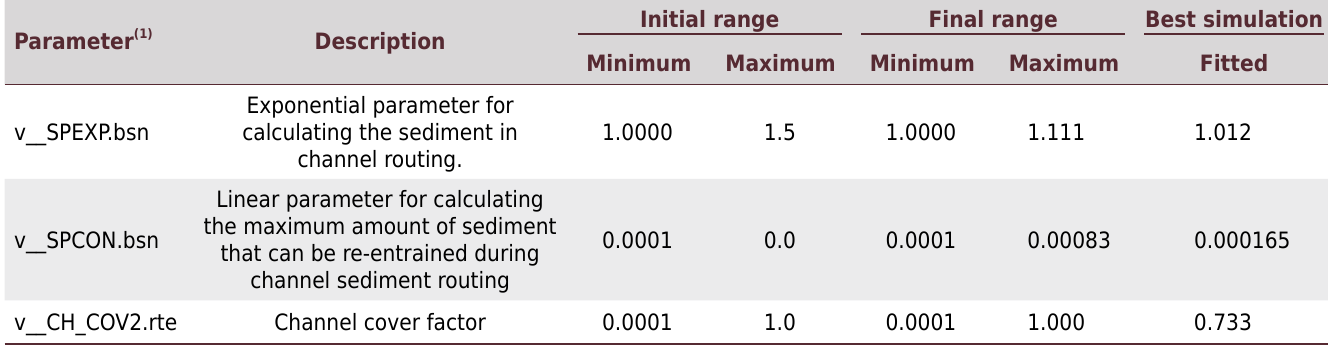
Table 3. Parameters used to calibrate the sediment load in Posses stream Parameter